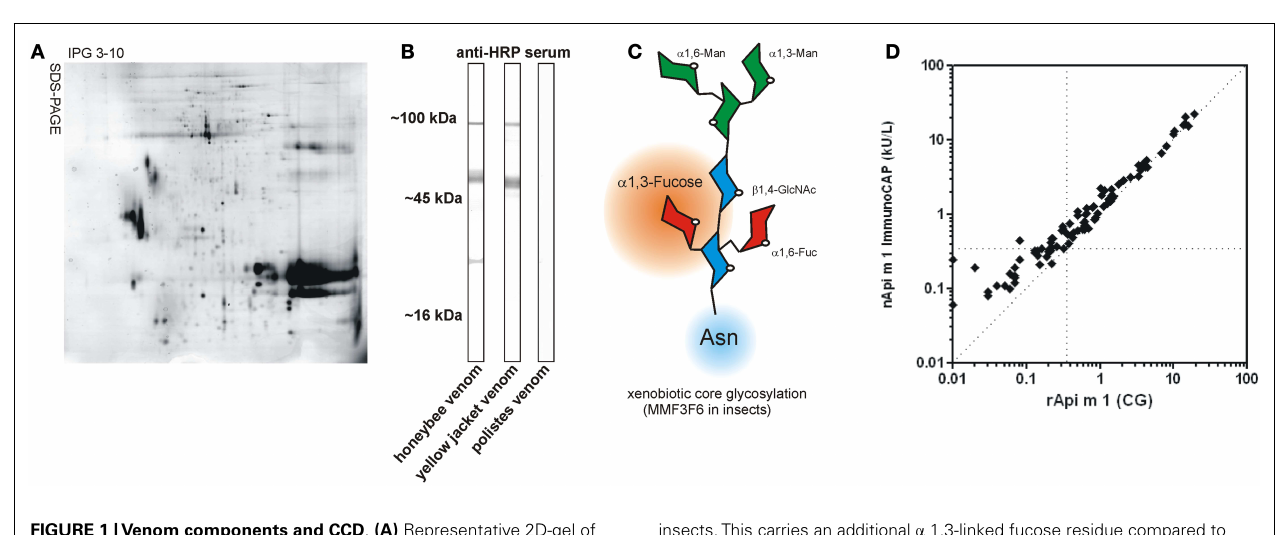
FIGURE 1 |Venom components and CCD . (A) Representative 2D-gel of the honeybee venom stained with Coomassie Brilliant Blue G-250 demonstrating the complexity of the venome (kindly provided by Dr. Nico Peiren, Laboratory of Zoophysiology, Ghent University, Belgium). (B) CCD sIgE-reactivity of rabbit anti-HRP serum with different Hymenoptera venoms in immunoblotting. Note the lack of CCD-reactivity in Polistes venom. (C) Schematic representation of xenobiotic core glycosylation as found in